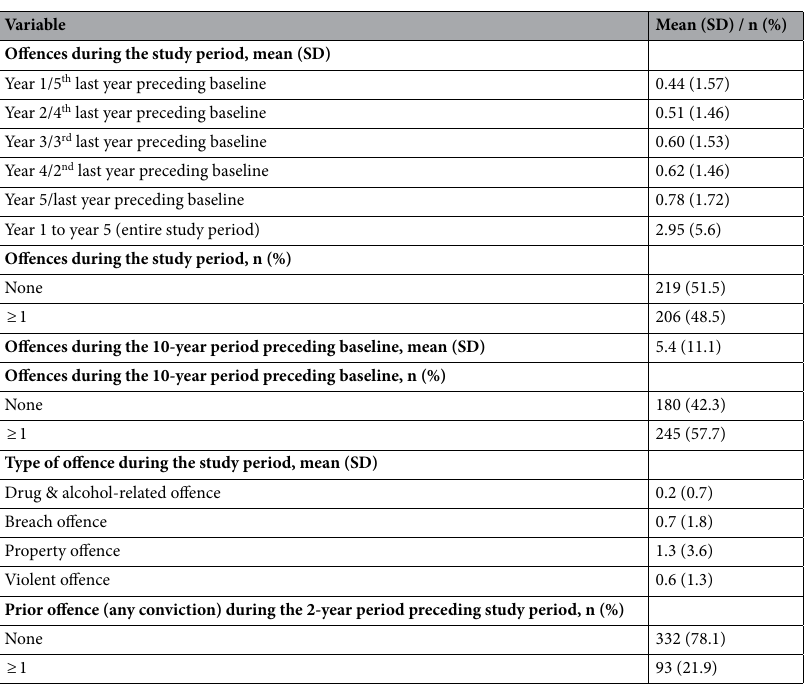
Table 2. Convicted offence-related characteristics of Vancouver At Home participants who consented to administrative data and could be linked (n = 425).